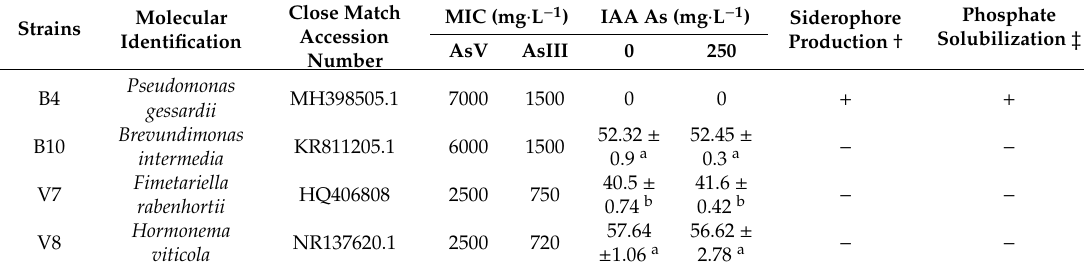
Table 3. Molecular identification, siderophore production, phosphate solubilization and minimum inhibition concentration (MIC) of the isolated bacterial and fungal strains, and the production of indoleacetic acid (IAA) by bacterial and fungi isolates in LB (Luria-Bertani) medium and 1 / 7 PDB (Potato Dextrose Broth), respectively, supplemented with concentrations of 0 and 250 mg · L − 1 of arsenic. Molecular Strains